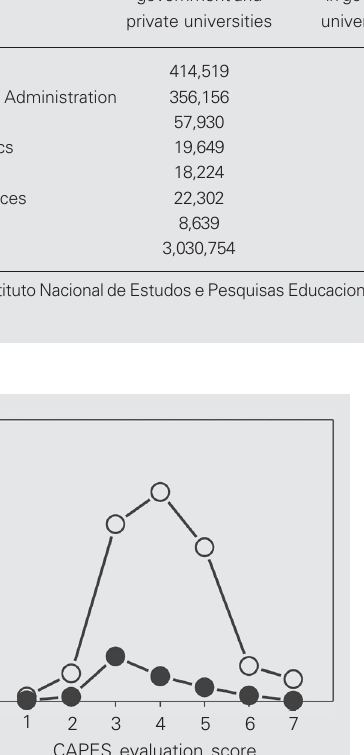
Table 1. Undergraduate enrollment and fields of knowledge taught in government and private universities. Fields of